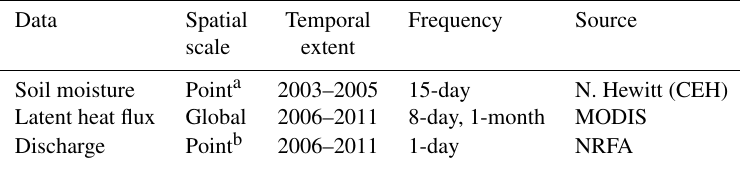
Table 1. Field measurements and remote sensing data.